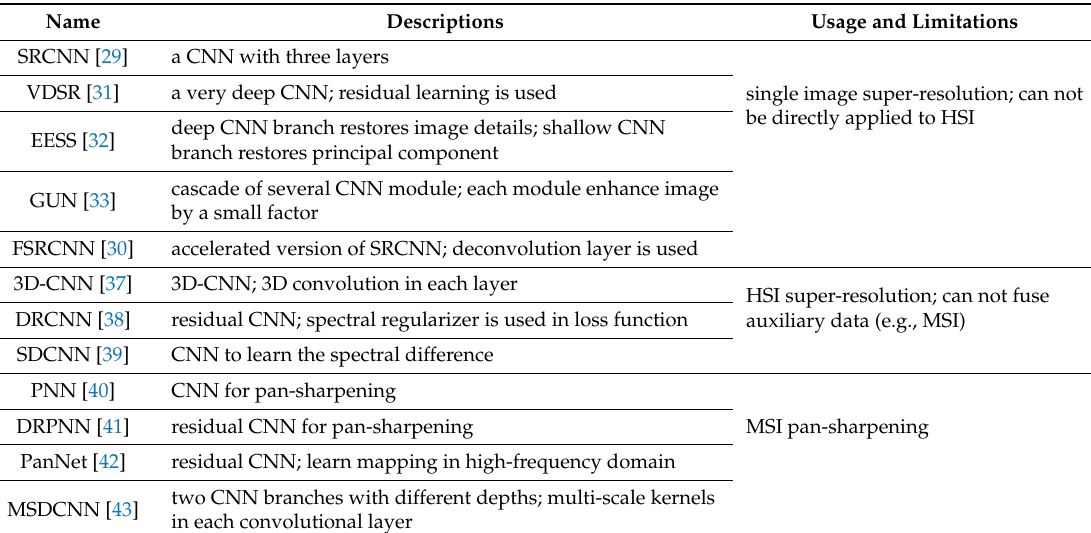
Table 1. A summary of CNN based image super-resolution